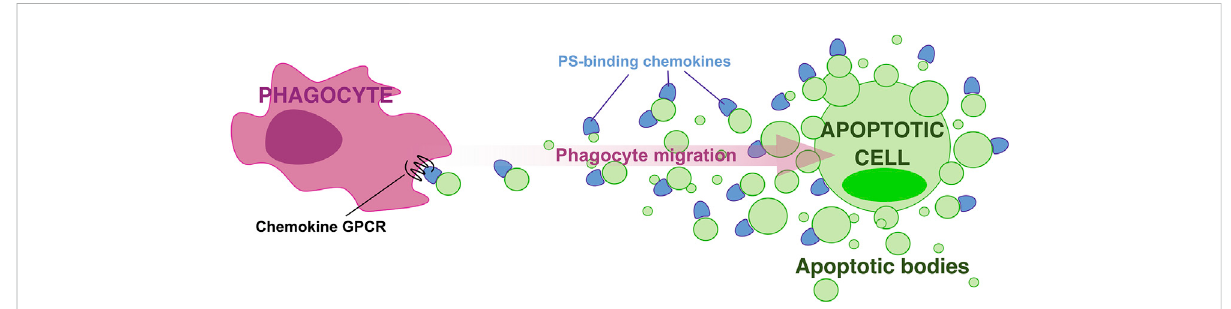
FIGURE 1 A “ breadcrumb ” modelfordirectedphagocytemigrationduringefferocytosis.AgradientofapoptoticbodiespresentingPS-boundchemokines on their surface direct phagocyte migration toward apoptotic